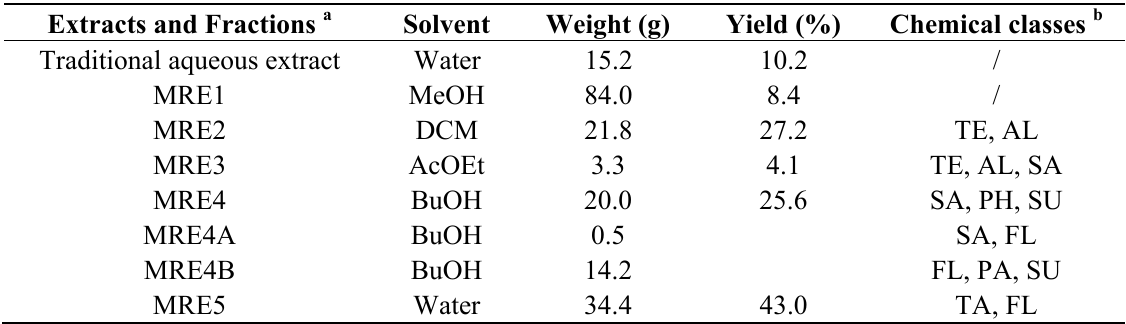
Table 1. Extraction yields and chemical classes of compounds found in the extracts and fractions from M.